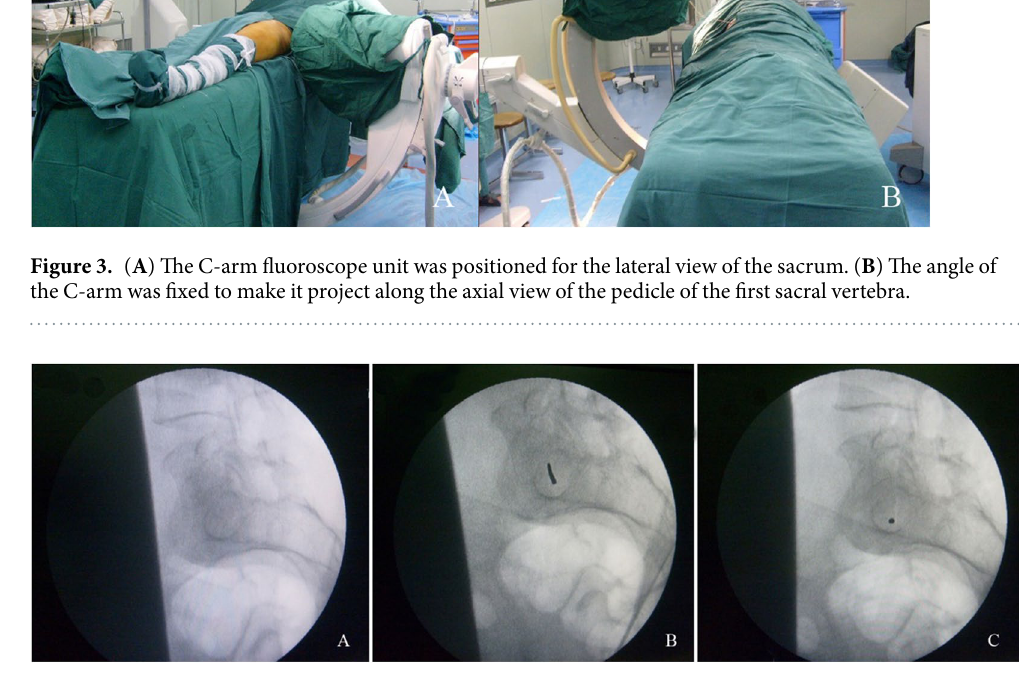
Figure 4. ( A ) A clear oval track image appeared on the fluoroscopy. ( B ) The starting point of the guide pin was located in the center of the oval track. ( C ) The projection of the guide pin became a point inside the oval